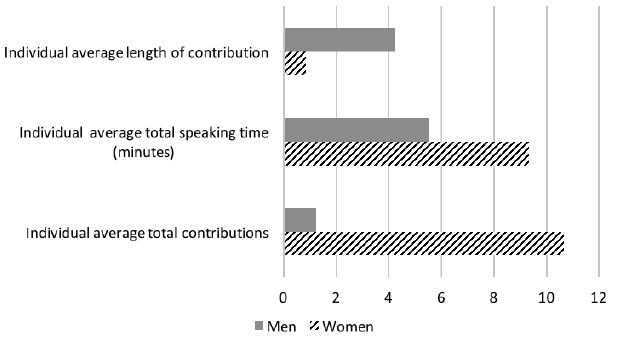
Fig. 11 . Gendered styles of participation from meetings 1 and 2, men’s and women’s information sharing